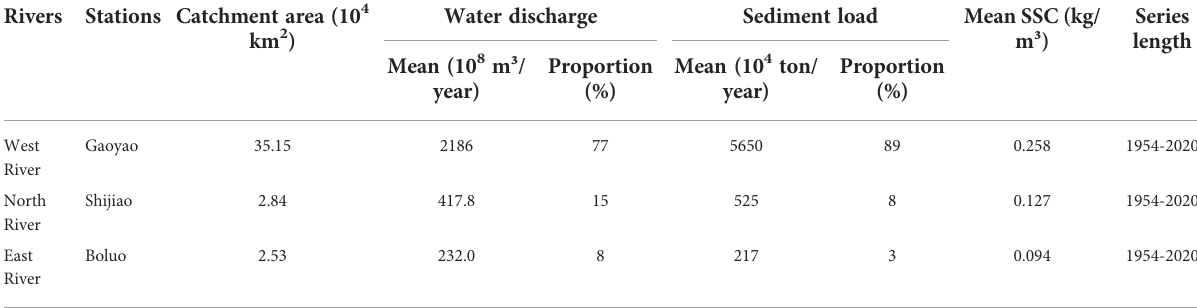
TABLE 1 General information of gauge stations on the main tributaries of the Pearl River in the Greater Bay Area. Rivers Stations Catchment area (10 4